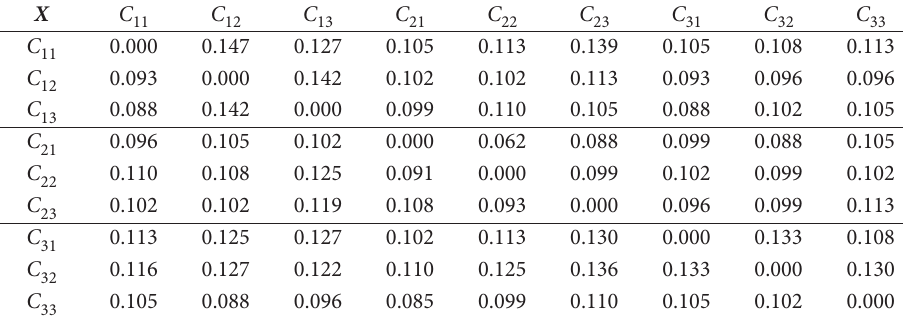
Table 4. The total influence-related matrix T (or called T